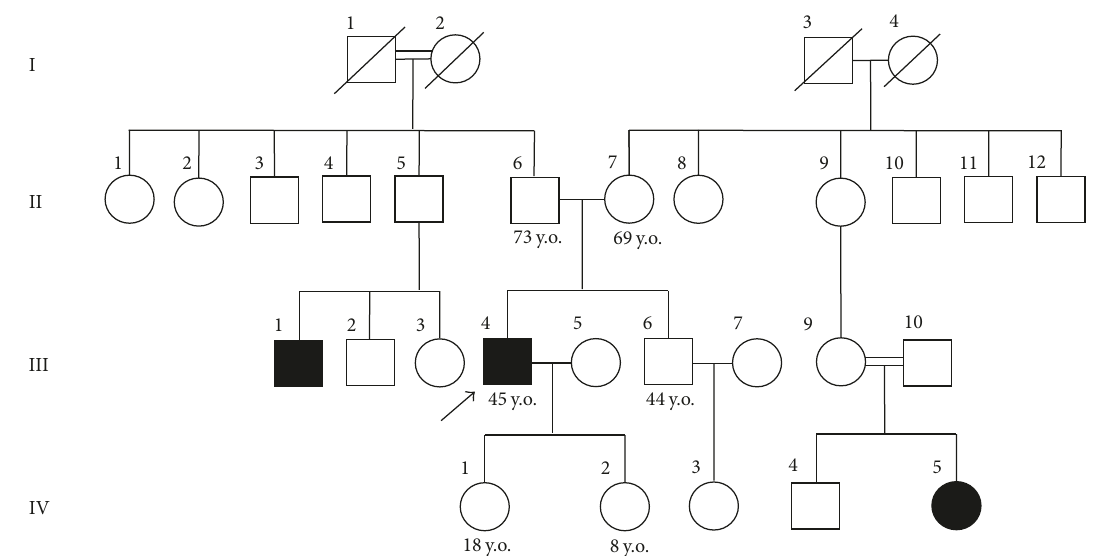
Figure 1: Genealogy of Proband U (III:4). An arrow indicates the Proband: black, affected family member; white, healthy family member. I, II, III, and IV are generations within the Proband’s family. III:1, manifestation at the age of 21 years (muscle weakness in the distal regions of the lower extremities). III:4, manifestation at the age of 26 years (muscle weakness in the posterior group of the lower leg muscles). IV:5, manifestation at the age of 21 years (muscle weakness in the distal regions of the lower